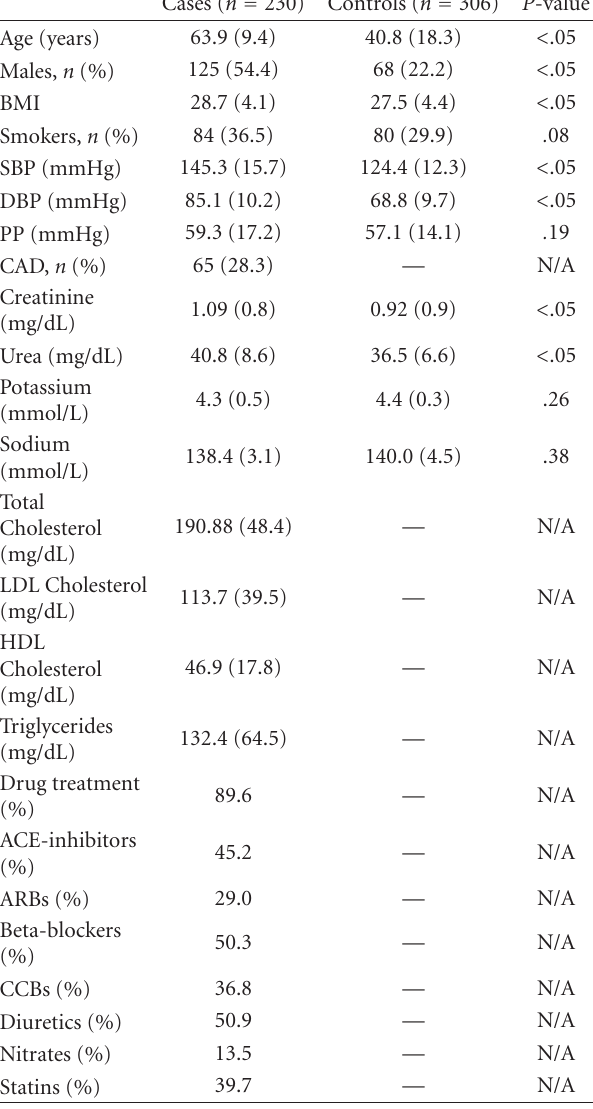
Table 1: Clinical characteristics of cases and